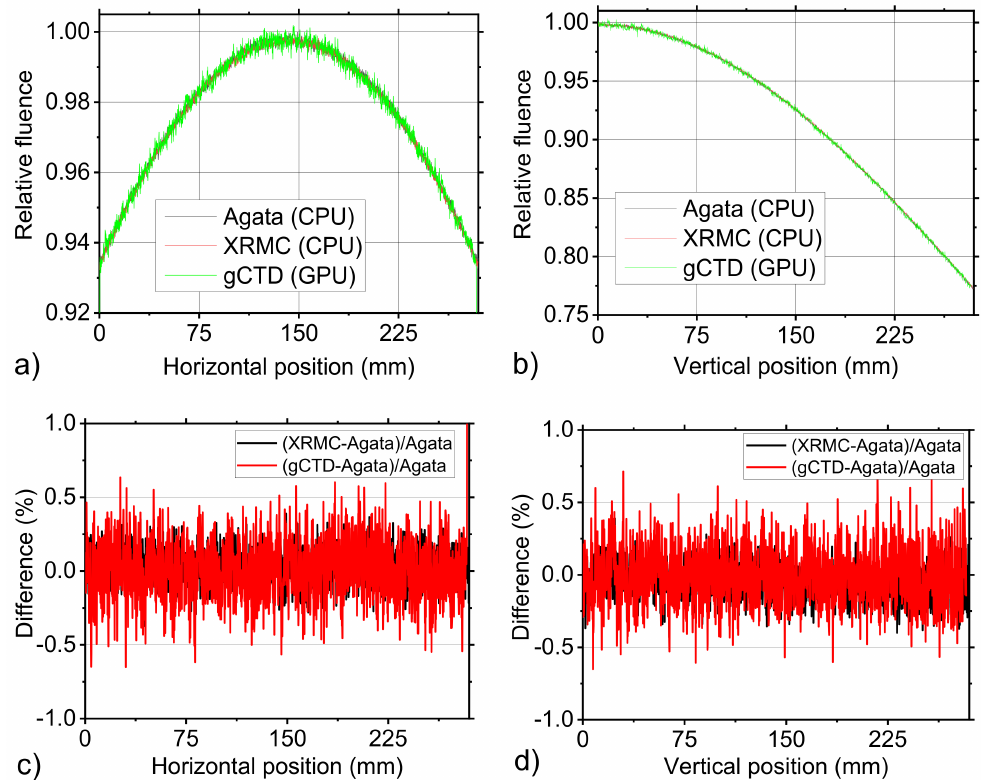
Figure 4. ( a ) Horizontal line profiles and ( b ) vertical line profiles of the normalized fluence values that were simulated with Agata, XRMC, and gCTD codes. The value was normalized to the highest value in the image. ( c ) and ( d ) are shown as the percentage difference between the values that were provided by the three simulation codes that were reported in ( a ) and in ( b ),